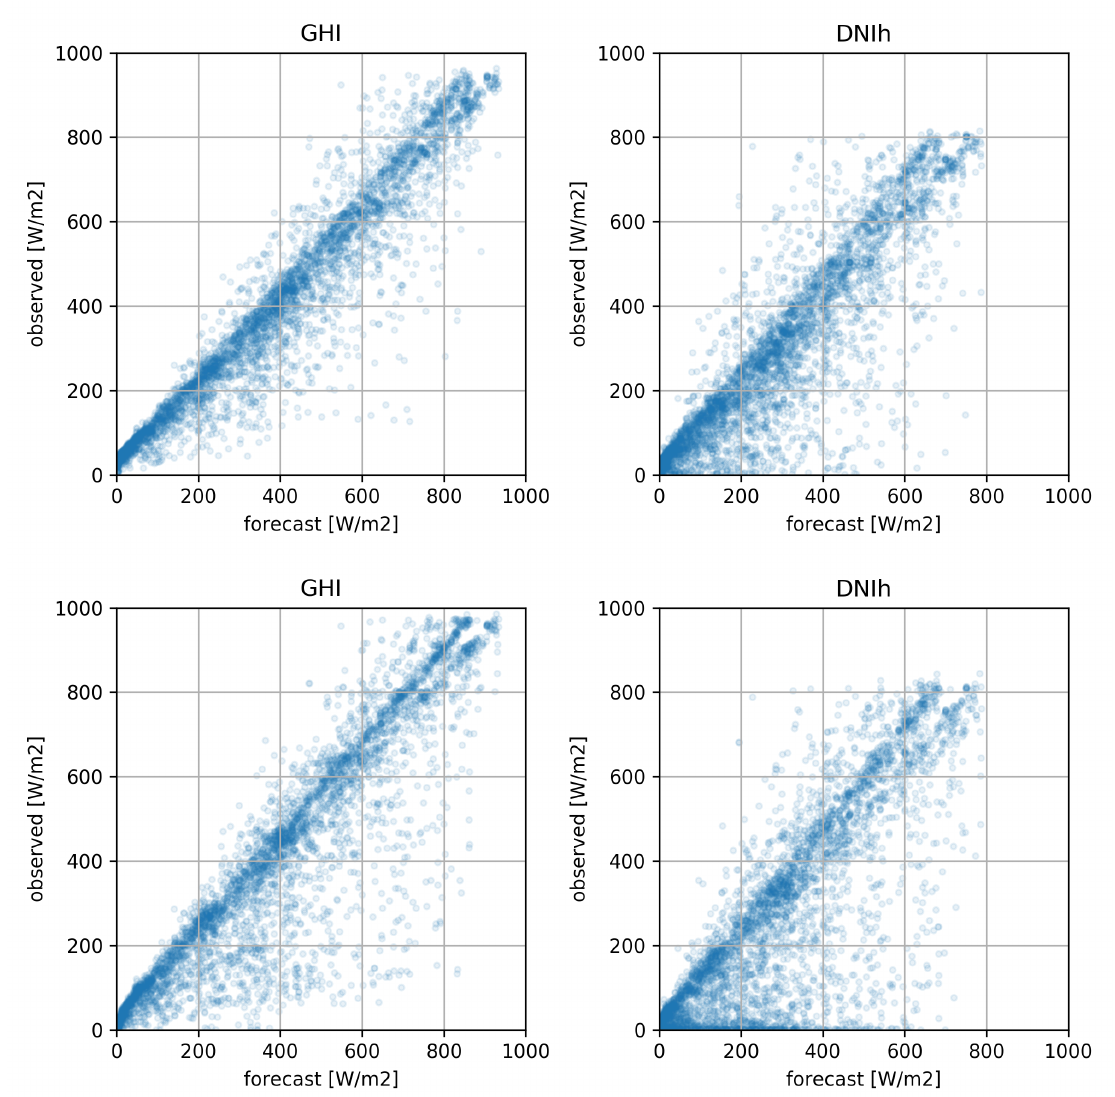
Figure 8. Scatterplot of modeled GHI and DNI irradiation on a horizontal surface compared to the measured values from the ERA5 ( top ) and SARAH ( bottom )